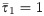
Diverse PRC shapes resulting from different ratios of light-induced transcription rates.(A), (B) PRCs for light signals with (A) Δτ = 1 h and (B) Δτ = 4 h. Different lines indicate results with the different ratios of light-induced transcription rates ϵ1/ϵt where ϵt = ϵ1 + ϵ2. (C) Area fraction of advance zone R in Eq (3) as a function of ϵ1/ϵt for different values of Δτ. In (A)-(C), the total light-induced transcription rate is fixed as ϵt = ϵ1 + ϵ2 = 1. The light-induced transcription rate of P2 is, then, ϵ2 = ϵt − ϵ1. We set τ¯1=1 h and τ¯2=1.5 h in Eq (1a). The values of the other parameters are described in S1 Text.